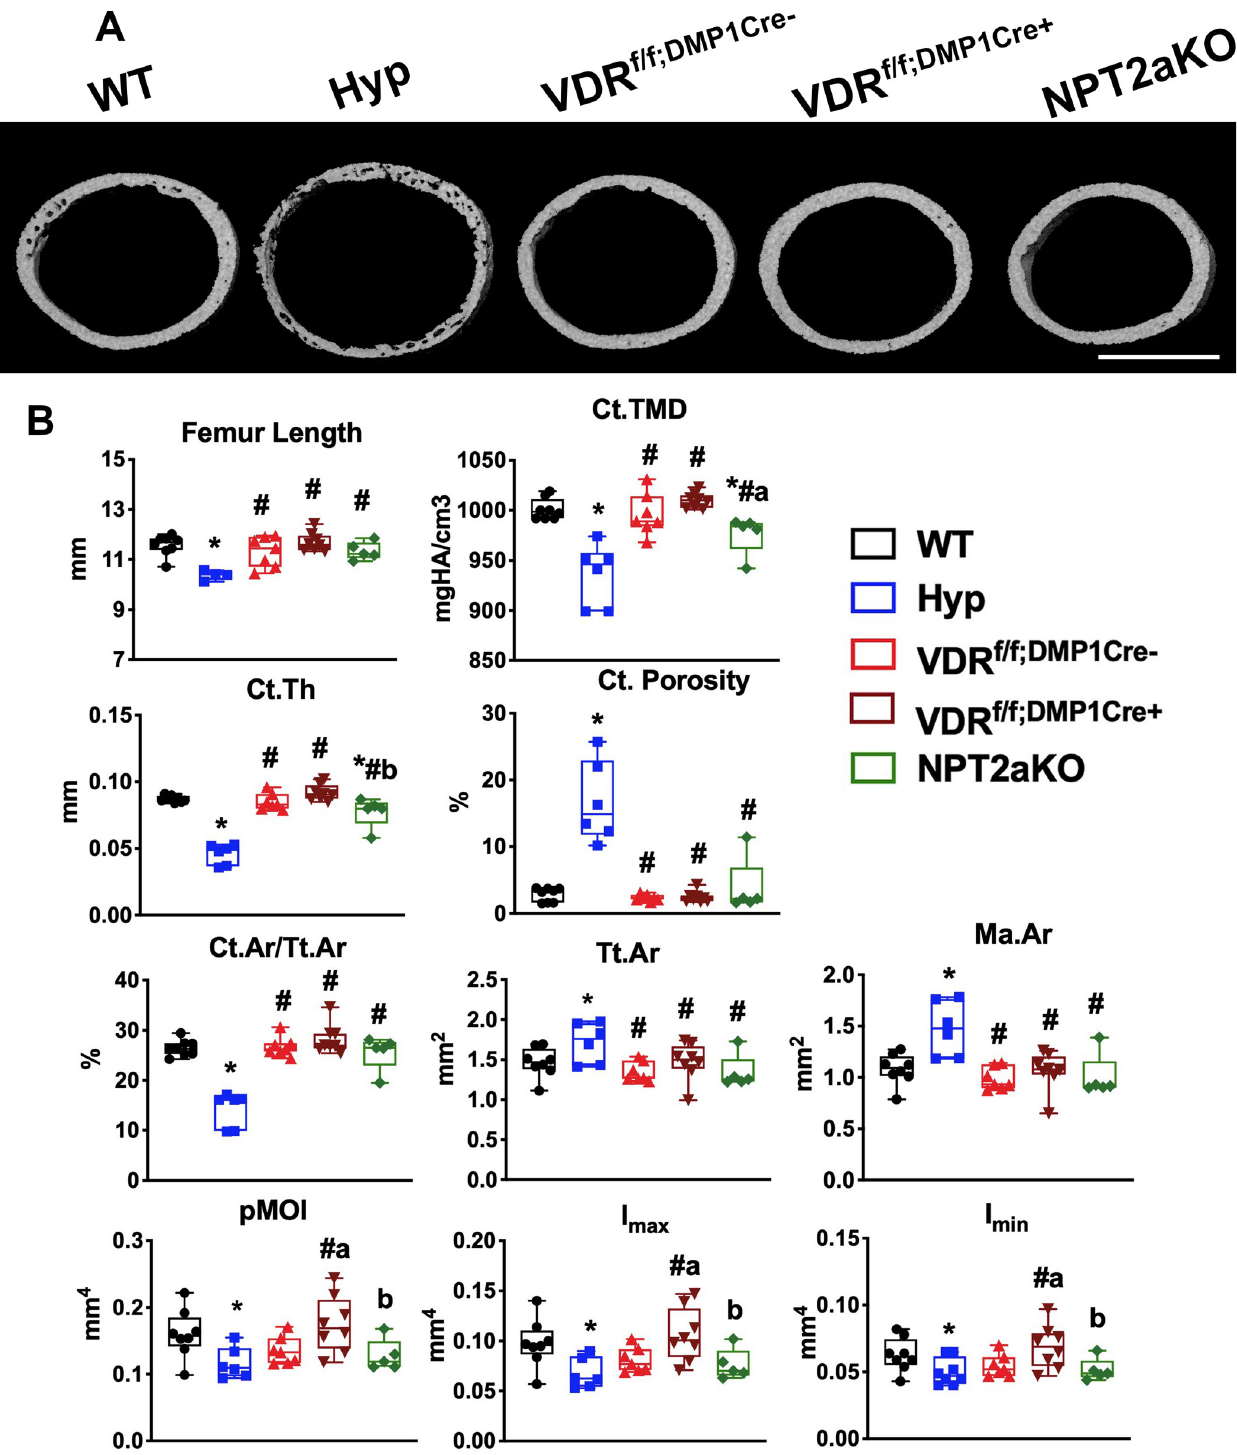
Fig 3. VDR f/f;DMP1Cre+ and NPT2aKO mice do not have significantly altered cortical microarchitecture. MicroCT was performed on d30 femurs isolated from WT, Hyp, VDR f/f;DMP1Cre- , VDR f/f;DMP1Cre+ and NPT2aKO mice. (A) Representative images of microCT scans are shown. Scale bar = 0.5 mm. (B) Cortical microCT parameters (Femur length, cortical tissue mineral density (Ct.TMD), cortical thickness (Ct.Th), cortical porosity (Ct.porosity), cortical area fraction (Ct.Ar/Tt.Ar), total area (Tt.Ar), medullary area (Ma.Ar), and polar moments of inertia (pMOI, I max , I min )) are shown. Data are representative of that obtained from at least 5 mice per genotype, with NPT2aKO mice including 2–3 mice of either sex and all other groups including 3–4 mice of either sex. � p < 0.05 vs WT, # p < 0.05 vs Hyp, a p < 0.05 vs VDR f/f;DMP1Cre- , b p < 0.05 vs VDR f/f;DMP1Cre+ .